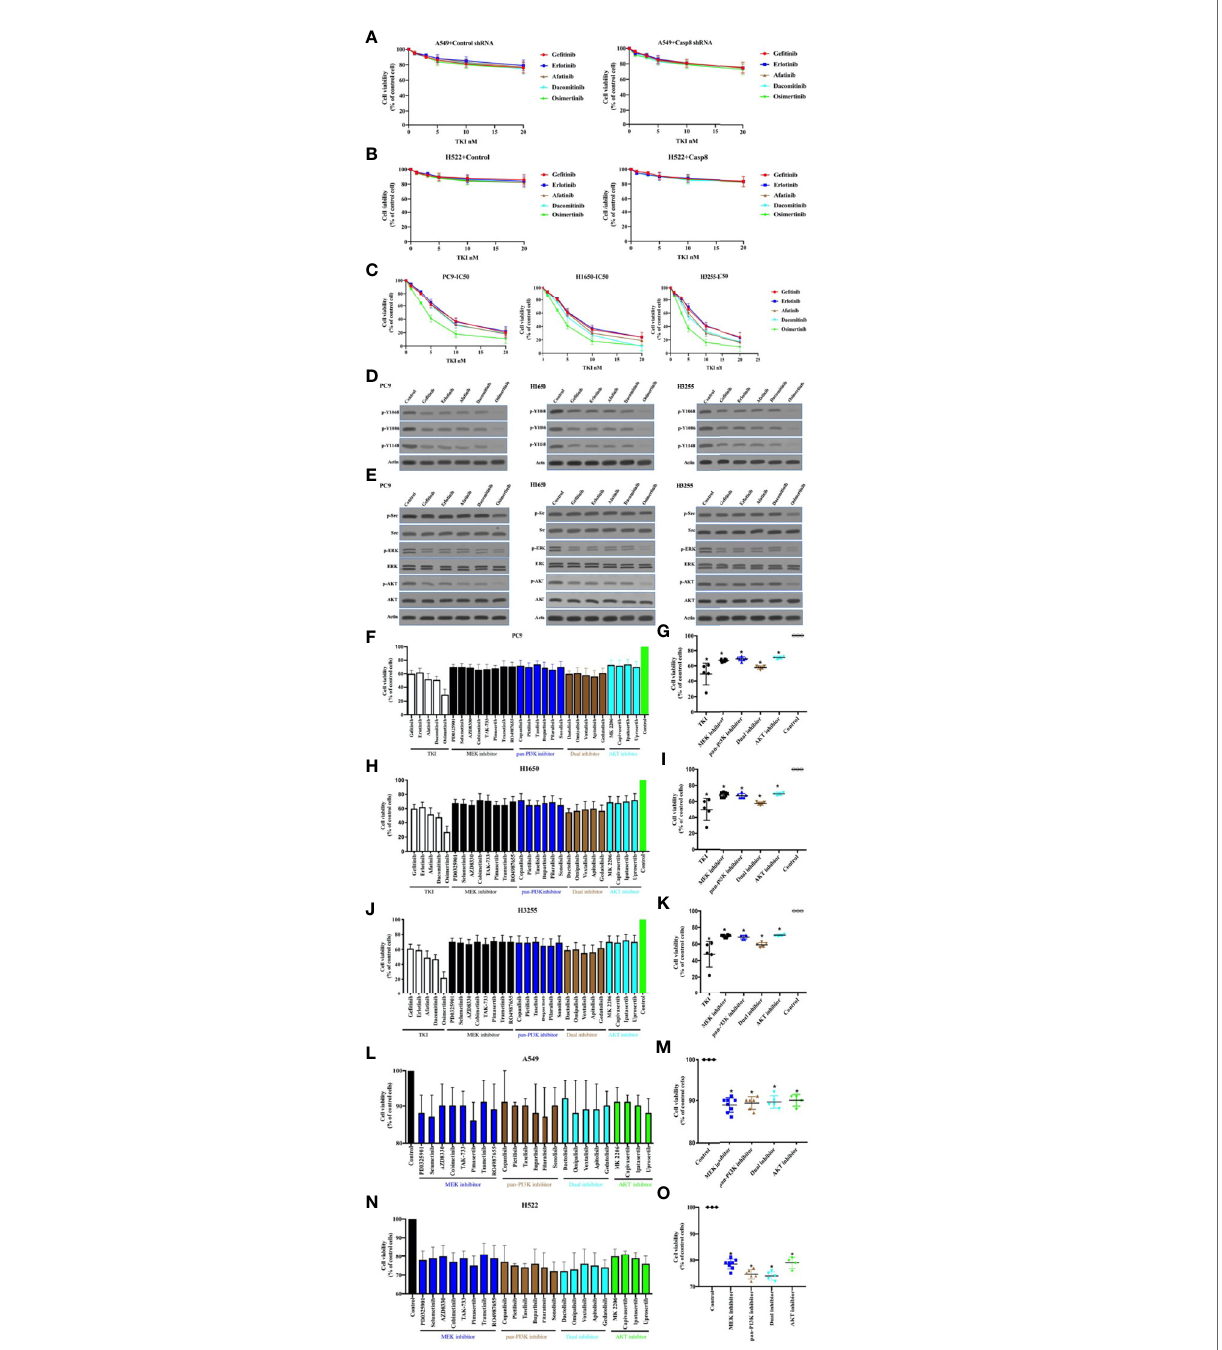
FIGURE 5 | TKIs blocked EGFR-related signaling to facilitate cell deaths of EGFR-mutant lung adenocarcinoma. (A) Viability assay of A549 cells with control shRNA or Casp8 shRNA attached on fi bronectin for 24 h treated by TKIs at indicated concentrations for 48 h ( n = 3). (B) Viability assay of H522 cells with control vector or Casp8 WT attached on fi bronectin for 24 h treated by TKIs at indicated concentrations for 48 h ( n = 3). (C) Viability assay of PC9, H1650 and H3255 cells treated by TKIs at indicated concentrations for 48 h ( n = 3). (D) Immunoblotting analysis of p-Y1068, p-Y1086, p-Y1148 of EGFR and b -actin in PC9, H1650 and H3255 cells. (E) Immunoblotting analysis of p-Src, c-Src, p-AKT, AKT, p-ERK, ERK and b -actin in PC9, H1650 and H3255 cells. (F, G) Viability assay of PC9 cells treated by drugs indicated for 48 h ( n = 3). * vs. control, p < 0.05. (H, I) Viability assay of H1650 cells treated by drugs indicated for 48 h ( n = 3). * vs. control, p < 0.05. (J, K) Viability assay of H3255 cells treated by drugs indicated for 48 h ( n = 3). * vs. control, p < 0.05. (L, M) Viability assay of A549 cells attached on fi bronectin for 24 h treated by drugs indicated for 48 h ( n = 3). * vs. control, p < 0.05. (N, O) Viability assay of H522 cells attached on fi bronectin for 24 h treated by drugs indicated for 48 h ( n = 3). * vs. control, p <